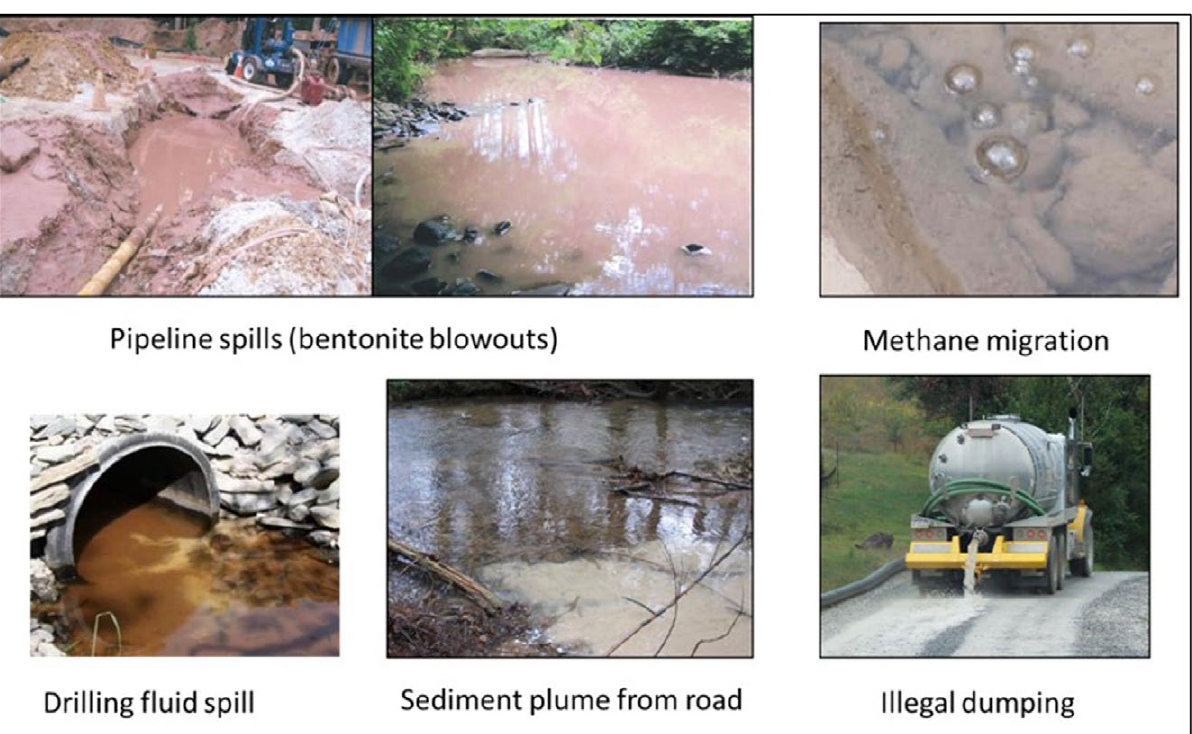
Figure 12: Photographs taken by volunteers to document observed disturbances and pollution events. (Photograph credits from top left, clockwise: Mountain Watershed Association (2), ALLARM, Wetzel County Action Group, PA Council of Trout Unlimited, Delaware Riverkeeper